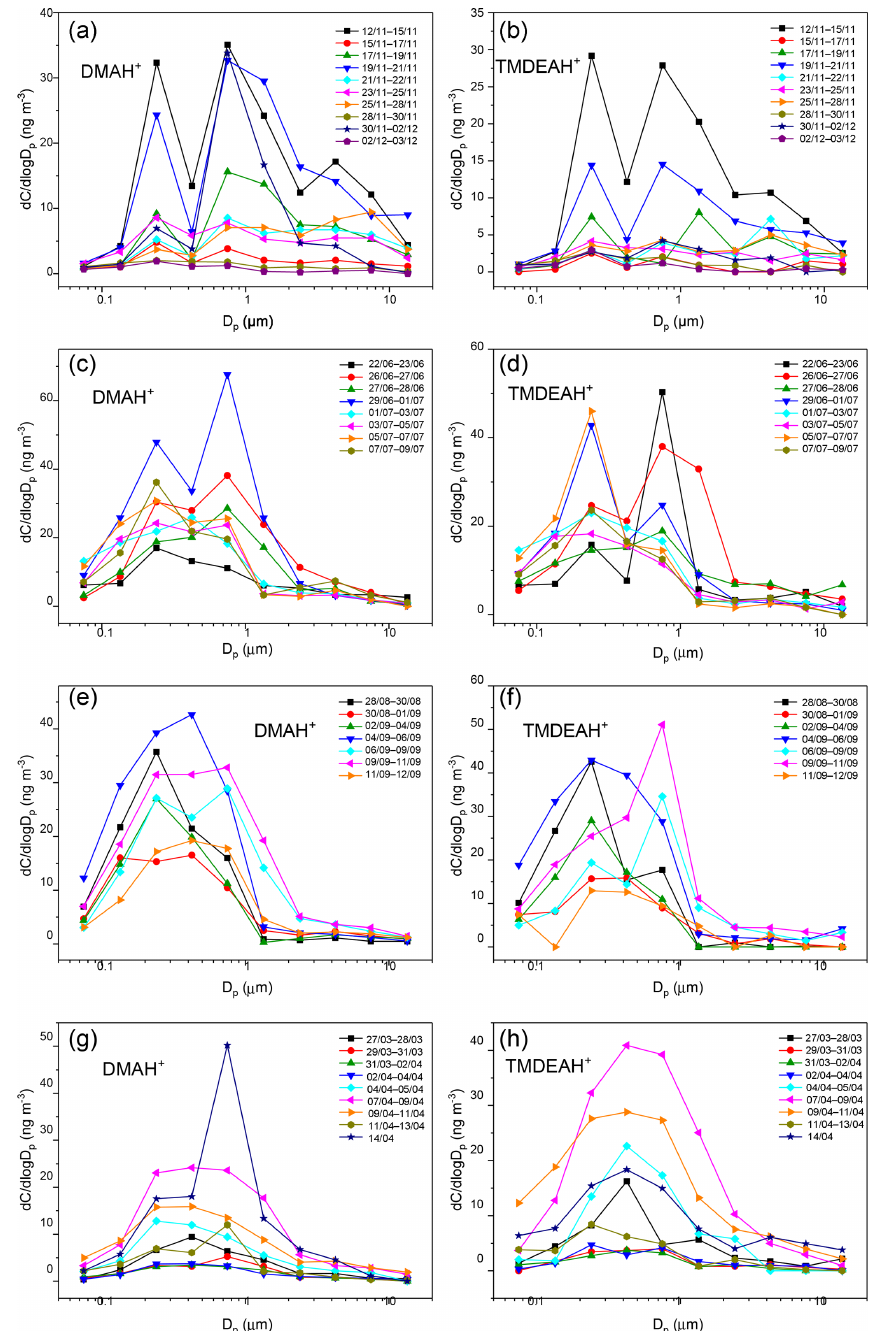
Figure 5. Size distributions of aminiums during different campaigns: (a–b) in the autumn of 2016 on Huaniao Island, (c–d) in early summer 2017 on Huaniao Island, (e–f) in late summer 2017 on Huaniao Island, and (g–h) during the 2017 spring cruise over the Yellow and East China